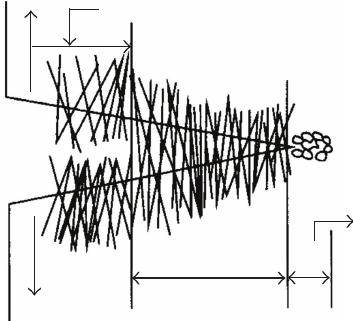
Figure 1: Sketch of fracture of fiber reinforced concrete.